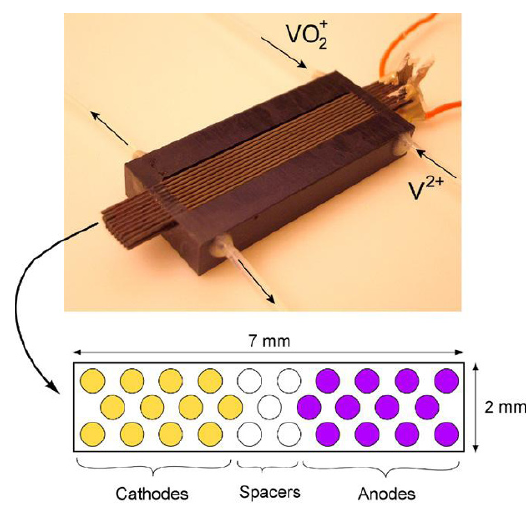
Figure 7. Graphite rod-based hexagonal microfluidic fuel cell array [35], Copyright Elsevier